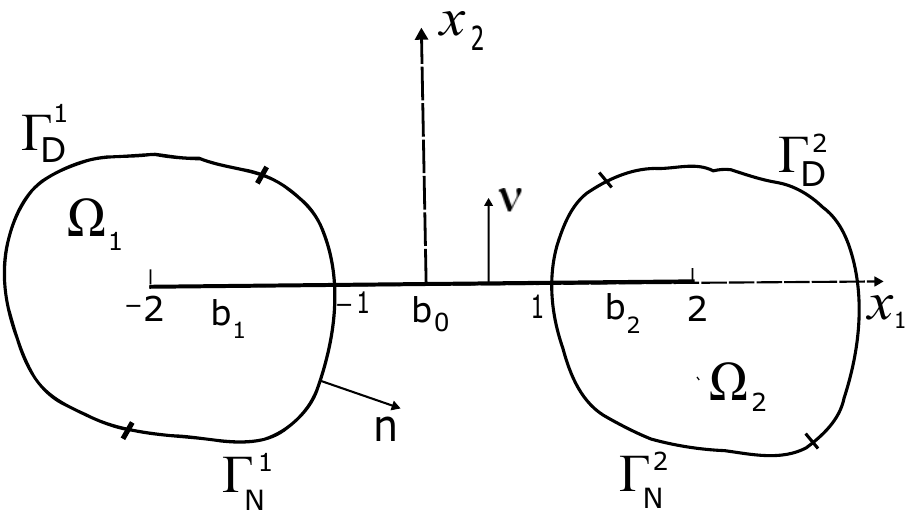
Figure 1. Elastic plates Ω 1 , Ω 2 with crossing bridge b